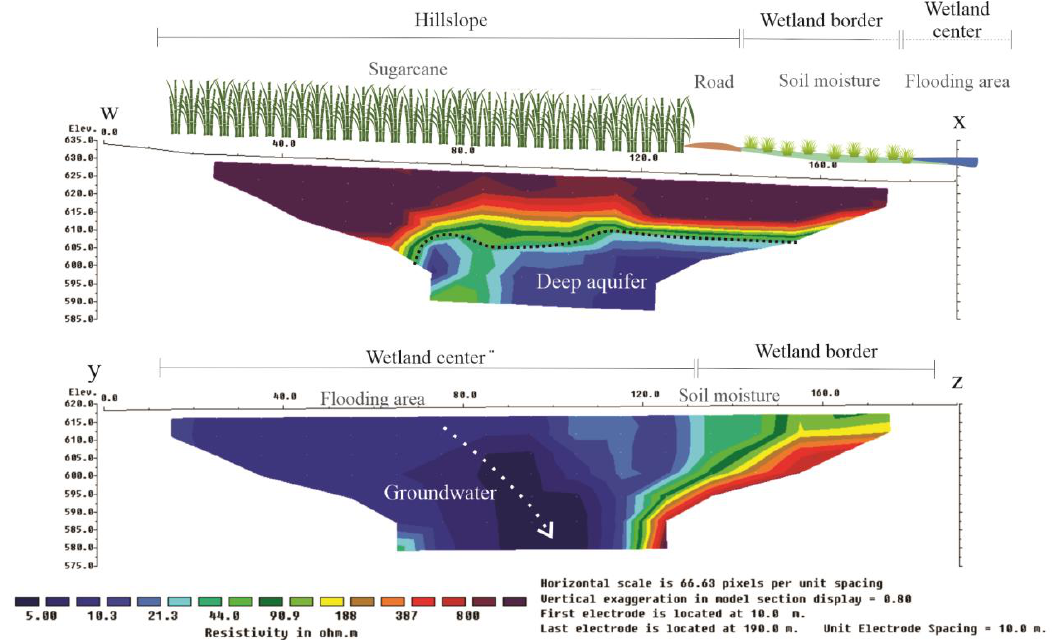
Figure 7. (w–x; y–z) 2D Inversion resistivity models, acquired based on Schlumberger array.